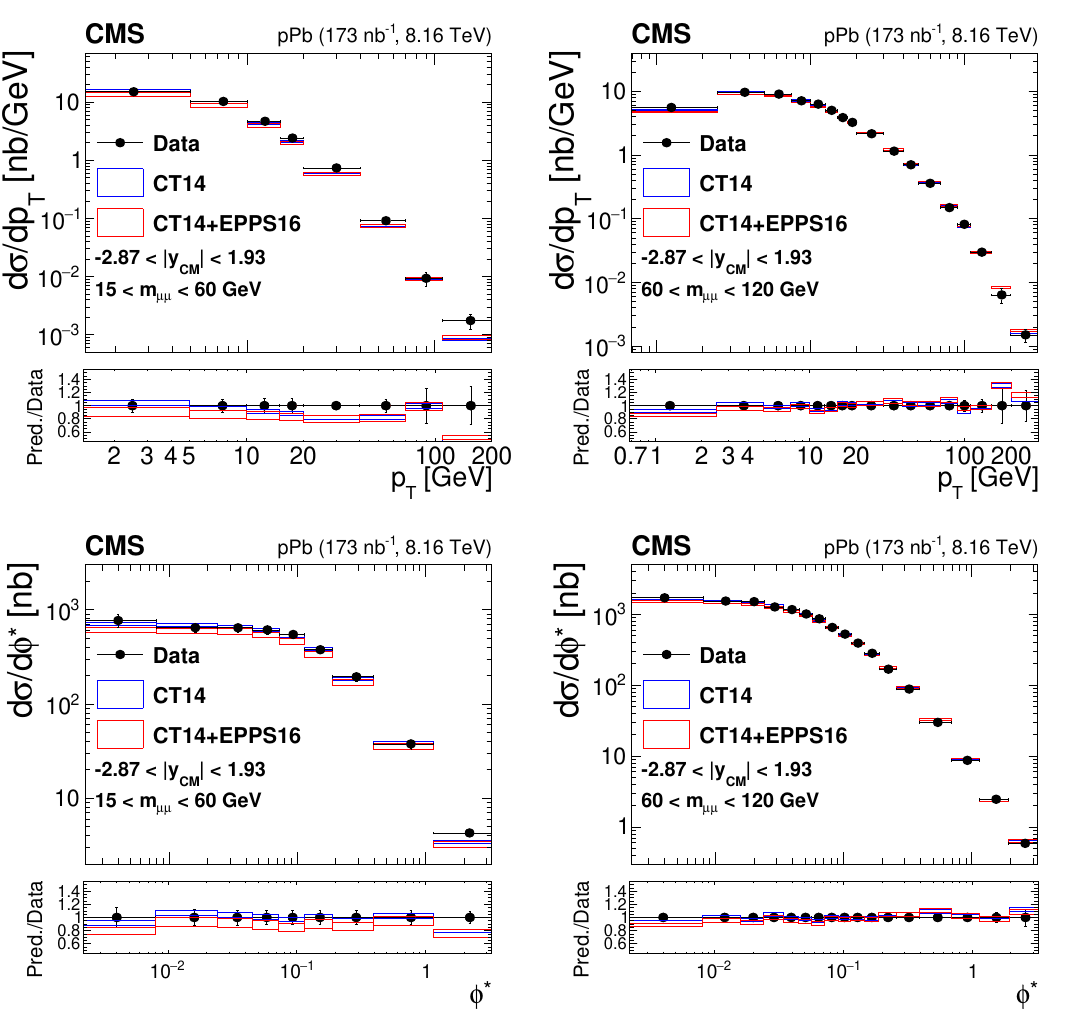
Figure 8 . Differential cross sections for the DY process measured in the muon channel, as functions of p (upper row) and φ ∗ (lower row), for 15 < m < 60 GeV (left) and 60 < m < 120 GeV T mm mm (right). The first bin of the p and φ ∗ measurements starts at 0. The error bars on the data T represent the quadratic sum of the statistical and systematic uncertainties. Theory predictions from the powheg NLO generator are also shown, using CT14 (blue) or CT14+EPPS16 (red). The boxes show the 68% confidence level (n)PDF uncertainty on these predictions. The ratios of predictions over data are shown in the lower panels, where the data and (n)PDF uncertainties are shown separately, as error bars around one and as coloured boxes,